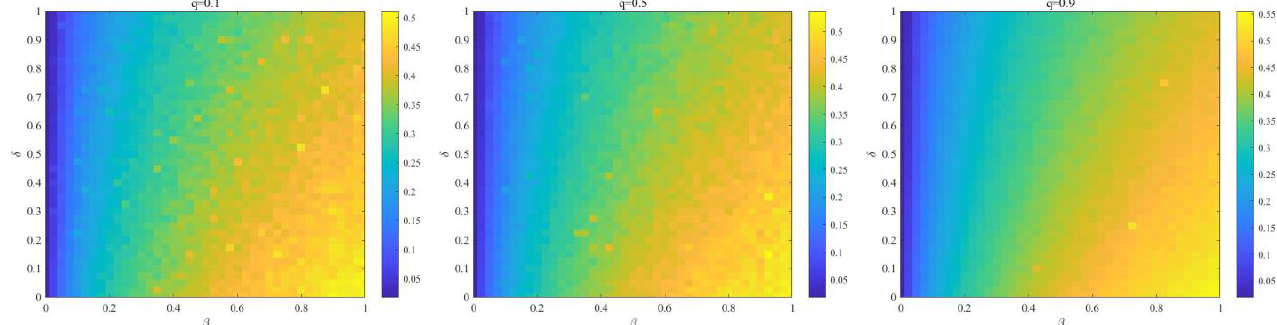
Figure 9. The full-phase diagram δ − β for different values of q . The color represents the proportion ρ R of recovered enterprise under steady state, other parameters are set as α = 5, m = 2, m 1 = 5, m 2 = 7, κ = 2, η = 0.8, µ = 0.8, λ = 0.8, γ = 0, θ = 0.